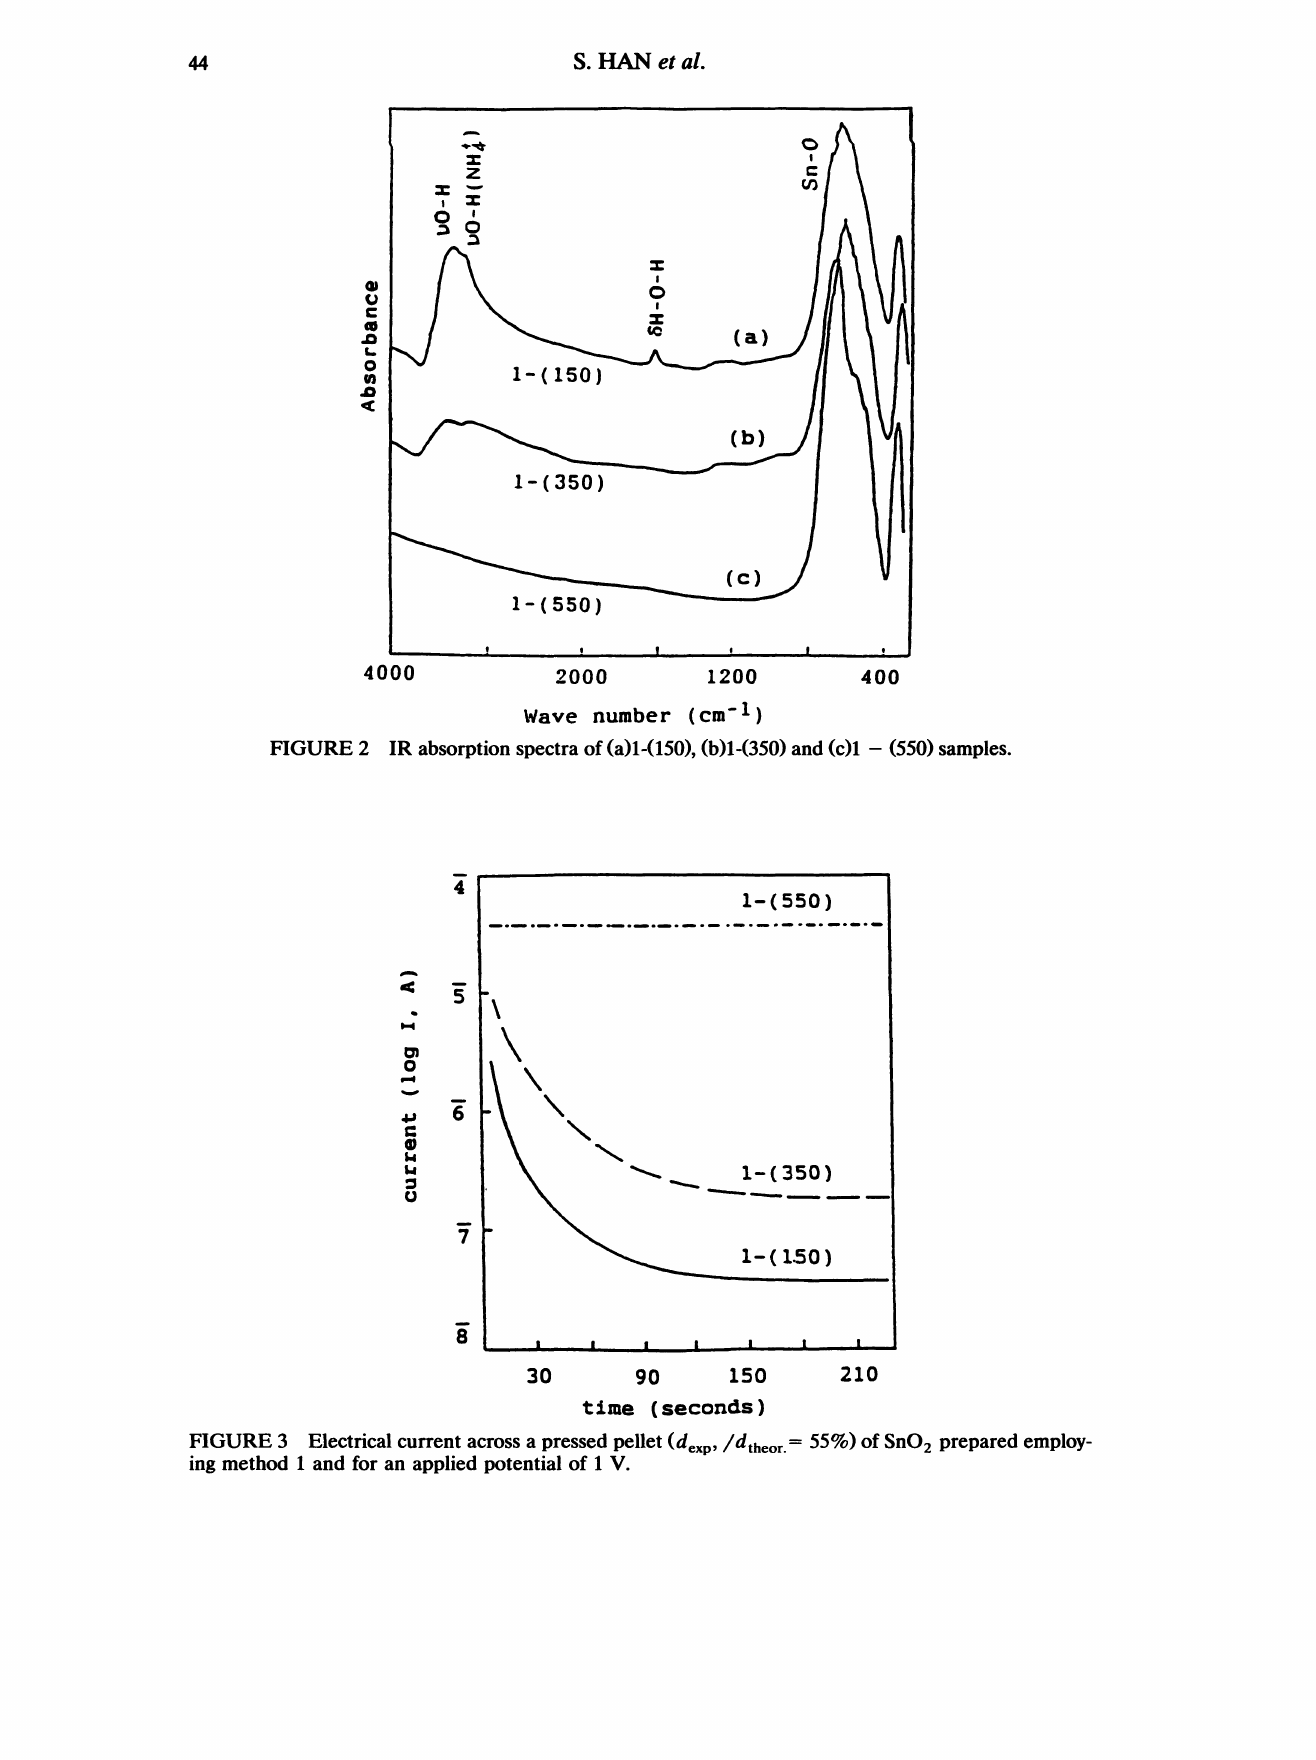
FIGURE 3 Electrical current across a pressed pellet (dexp,/dtheor.-" 55%) of SilO prepared employ- ing method and for an applied potential of